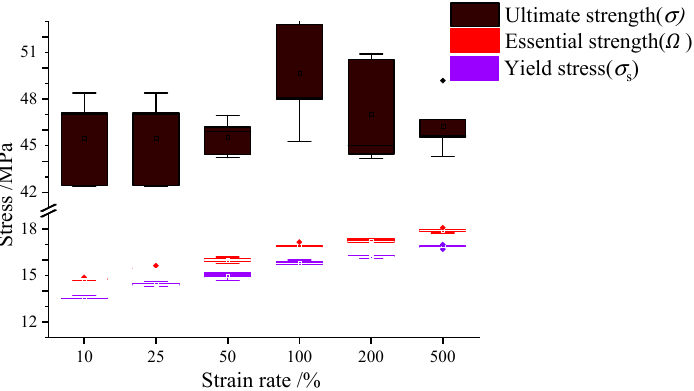
Figure 5. The distributions of essential strengths, yield stresses, and ultimate strengths.